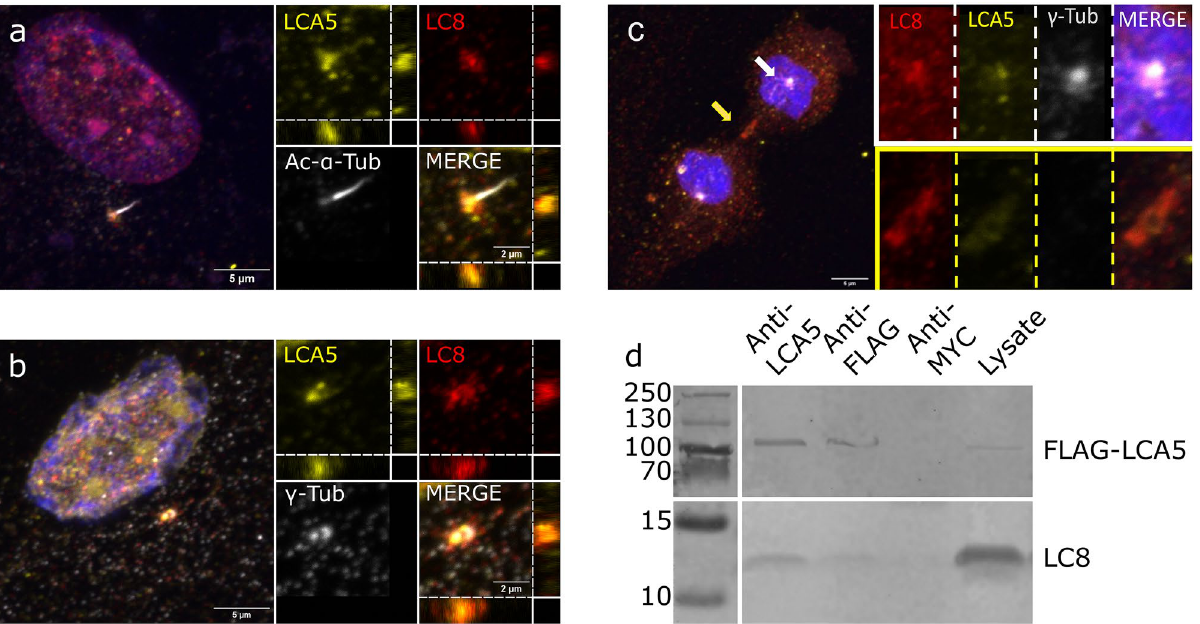
Figure 1. Colocalization and co-immunoprecipitation of LC8 and LCA5. ( a ) LCA5 and LC8 colocalize at the ciliary basal body of hTERT-RPE1 cells, with zx and zy cross-sections at the basal body. The brightness of the intersections was adjusted for better visibility ( b ) Colocalization in the centrosome in late interphase cells at both the mother and daughter centrioles. A zx and zy cross-section shows the overlapping at the centrioles. The brightness of the intersections was adjusted for better visibility (c ) In dividing cells, LCA5 and LC8 show a strong colocalization around the centrioles (white framed insert) and in the midbody (yellow framed insert). ( d ) Co-immunoprecipitation of LC8 with full-length FLAG-LCA5 in HEK293 cells. The FLAG-LCA5-LC8 interaction was detected by immunoprecipitation with anti-LCA5 and anti-FLAG antibodies, but no interaction was observed using the control antibody anti-MYC. The original image was cropped for better visibility (see the original blot in Supplementary Fig.